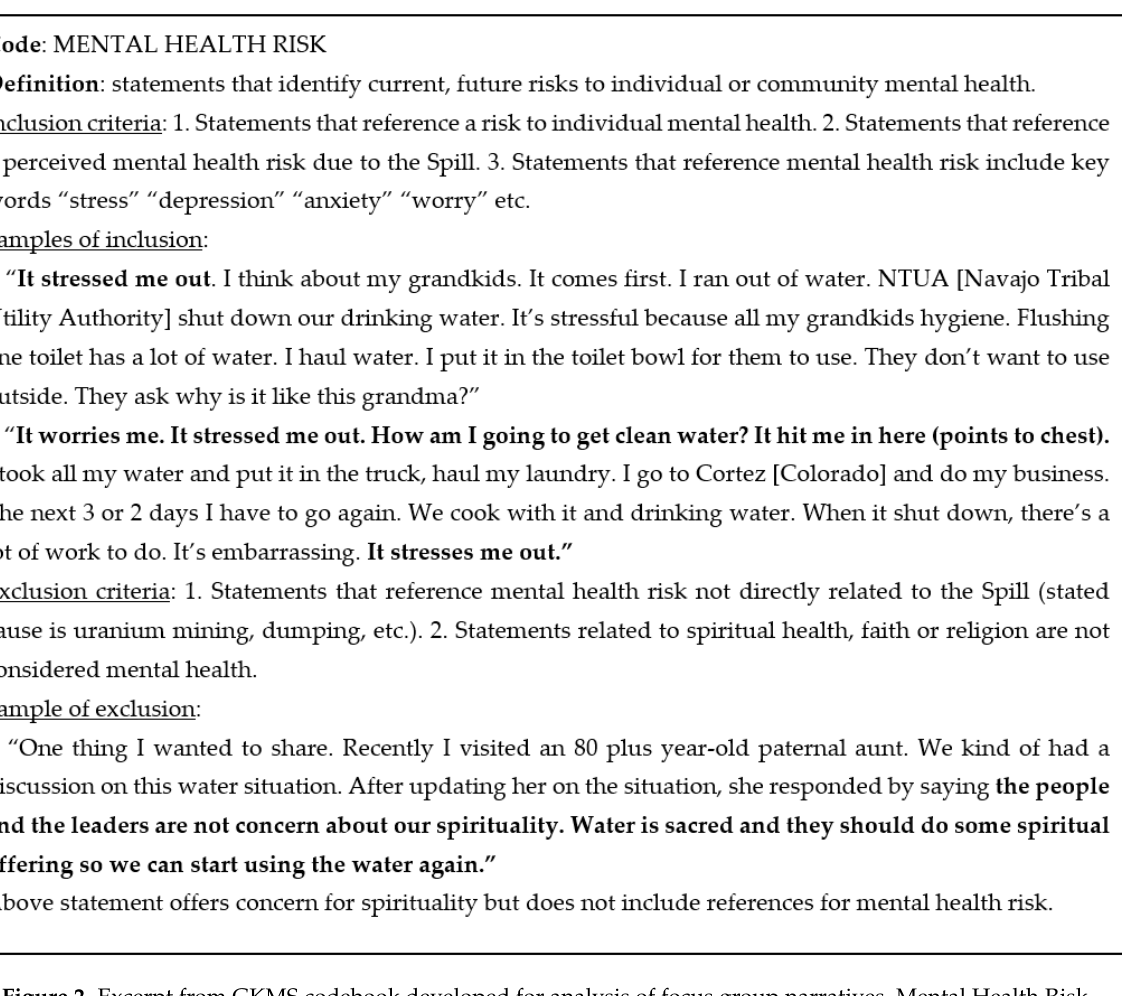
Figure 2. Excerpt from GKMS codebook developed for analysis of focus group narratives, Mental Health Risk. Pairs of coders, one Din é and one non-Din é , were assigned to code the same transcripts. The pairs were created without regard to field of expertise, university, previous coding experience or academic level (e.g., faculty or graduate student). The pairing process reflected the perspective of the team, respecting the insight of all coders and recognizing that previous coding experience and cultural insight were equally valuable to the validity of the outcomes. The pairs independently coded their assigned transcripts and then met in-person, via Zoom ® , or on the phone to discuss their results and reach consensus on sub-theme coding, resulting in a single set of coding outcomes. If consensus could not be reached, the passages would be shared with the larger group at the weekly meetings and the group would reach